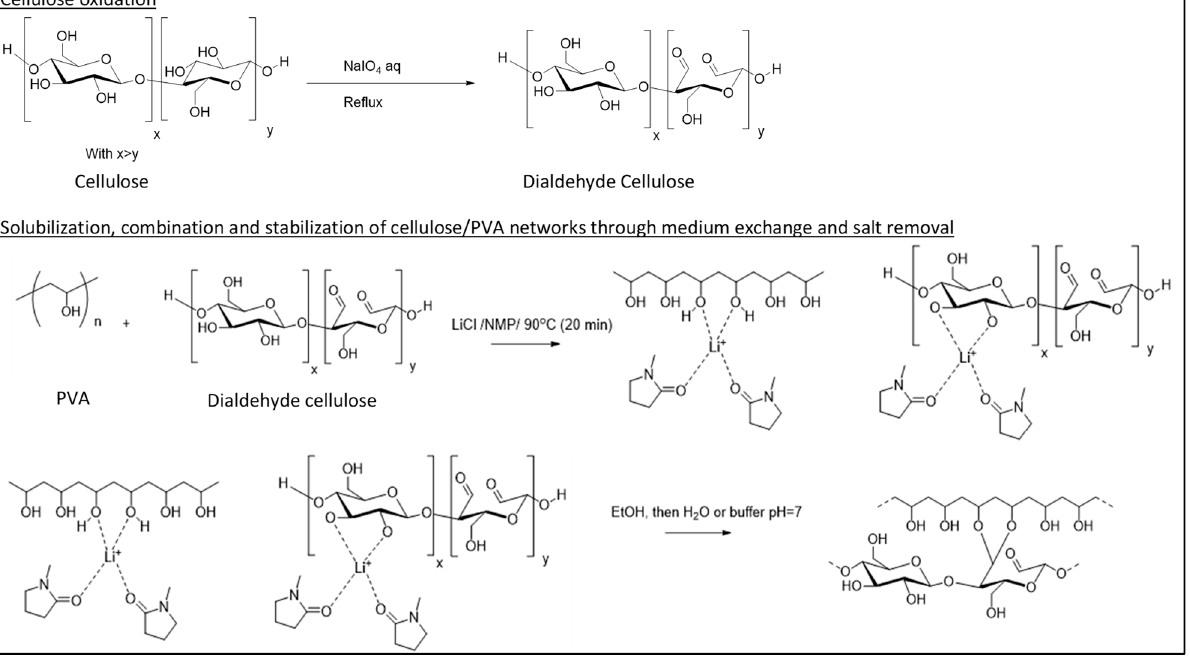
Figure 1. Reaction mechanisms of cellulose dialdehyde oxidation and formulation of cellulosic/PVA scaffolds. DAC/PVA ratio was also modulated to 1:1 and 1:2. Macro-porosity is promoted by 1 g/mL NaCl (0–500 µ m and 50–100 µ m; VWR Chemicals; Radnor, PA, USA) addition before casting. Long-term storage of the resulted DAC/PVA scaffolds was ensured in absolute ethanol at 4 ◦